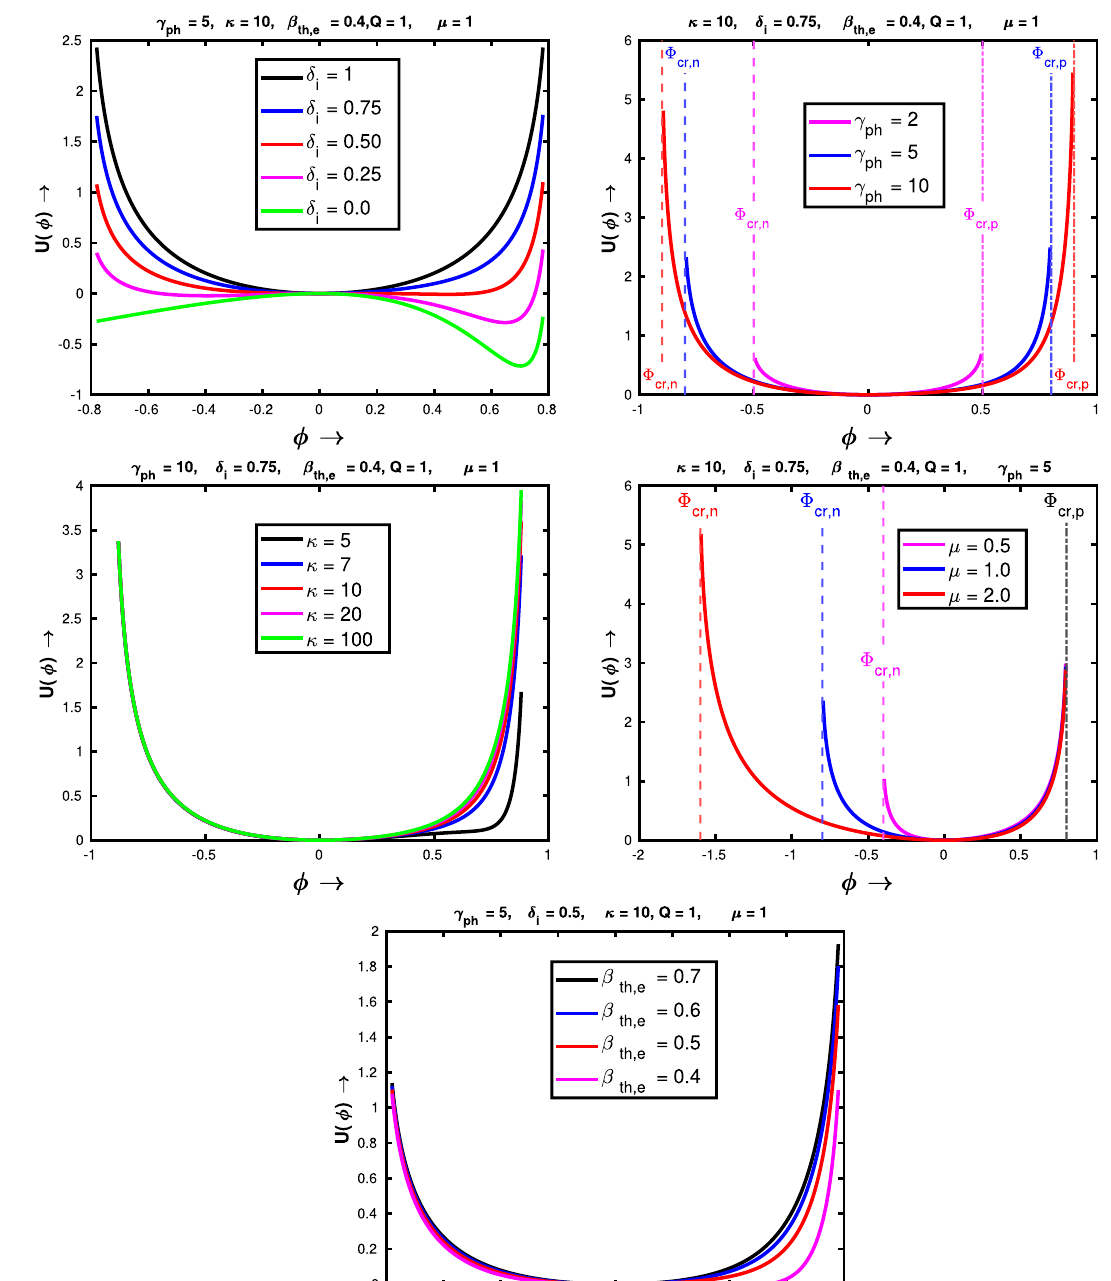
Figure 5. The variation of pseudopotential U (φ) as a function of φ for different values of the input parameters: negative-to-positive ion density ratio δ i (top left), Lorentz factor γ ph (top right), spectral index κ (middle left), negative-to-positive ion mass ratio µ (middle right) and normalised electron thermal energy β th , e